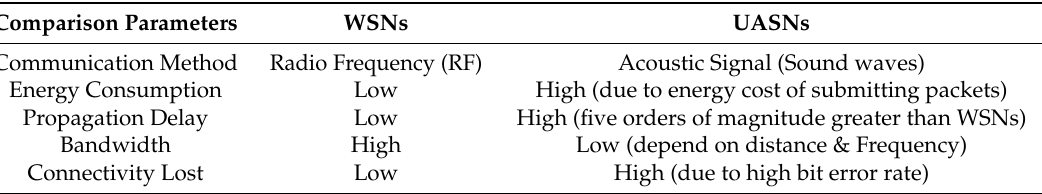
Table 1. Comparison of WSNs and